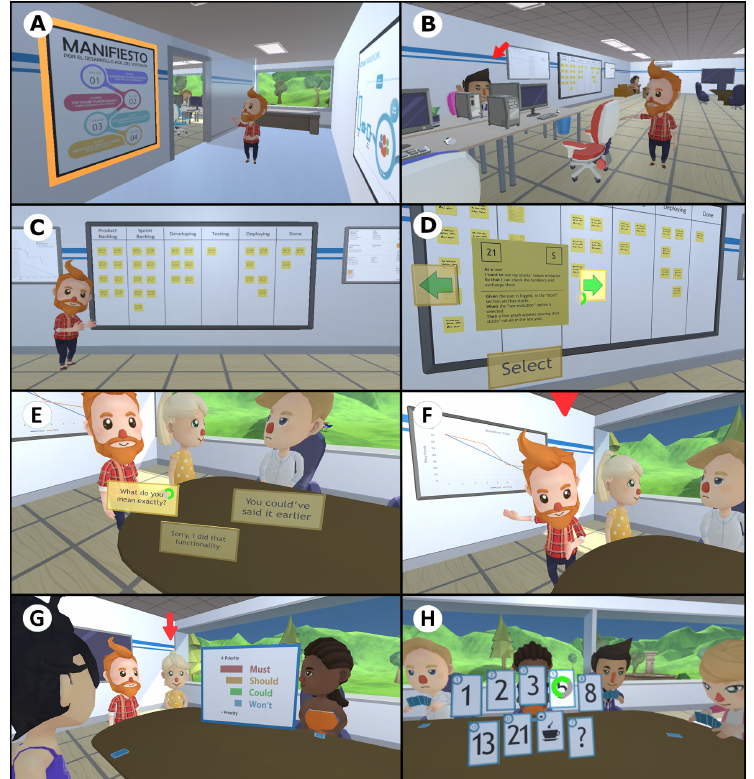
Figure 1. ( A ) The SM explaining the Agile manifesto. ( B ) The user meeting the developers. ( C ) The SM explaining the Kanban board. ( D ) The user selecting a user story based on its estimation and priority. ( E ) The user discussing a topic with the SM and the PO. ( F ) The SM explaining the Sprint performance through a Burndown chart. ( G ) The PO explaining the MSCW technique to prioritize user stories. ( H ) The user participating in Poker